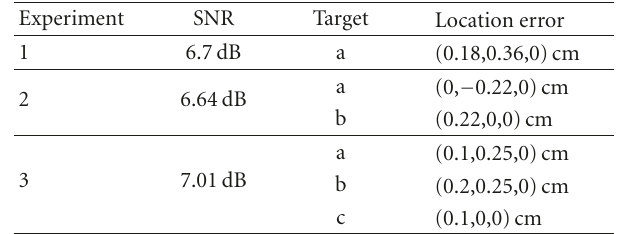
Table 2: Location errors and SNR values obtained in each